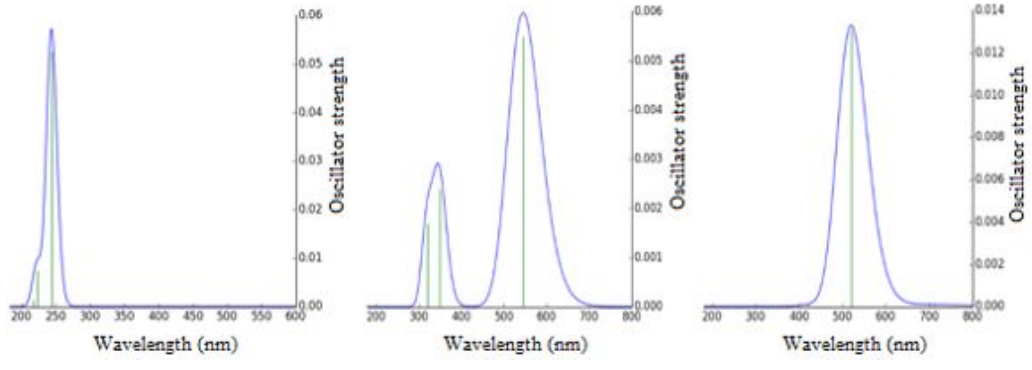
Figure 5: The UV-VIS spectra each of (a) dopamine, (b) L-DOPA, and (c) quinone.